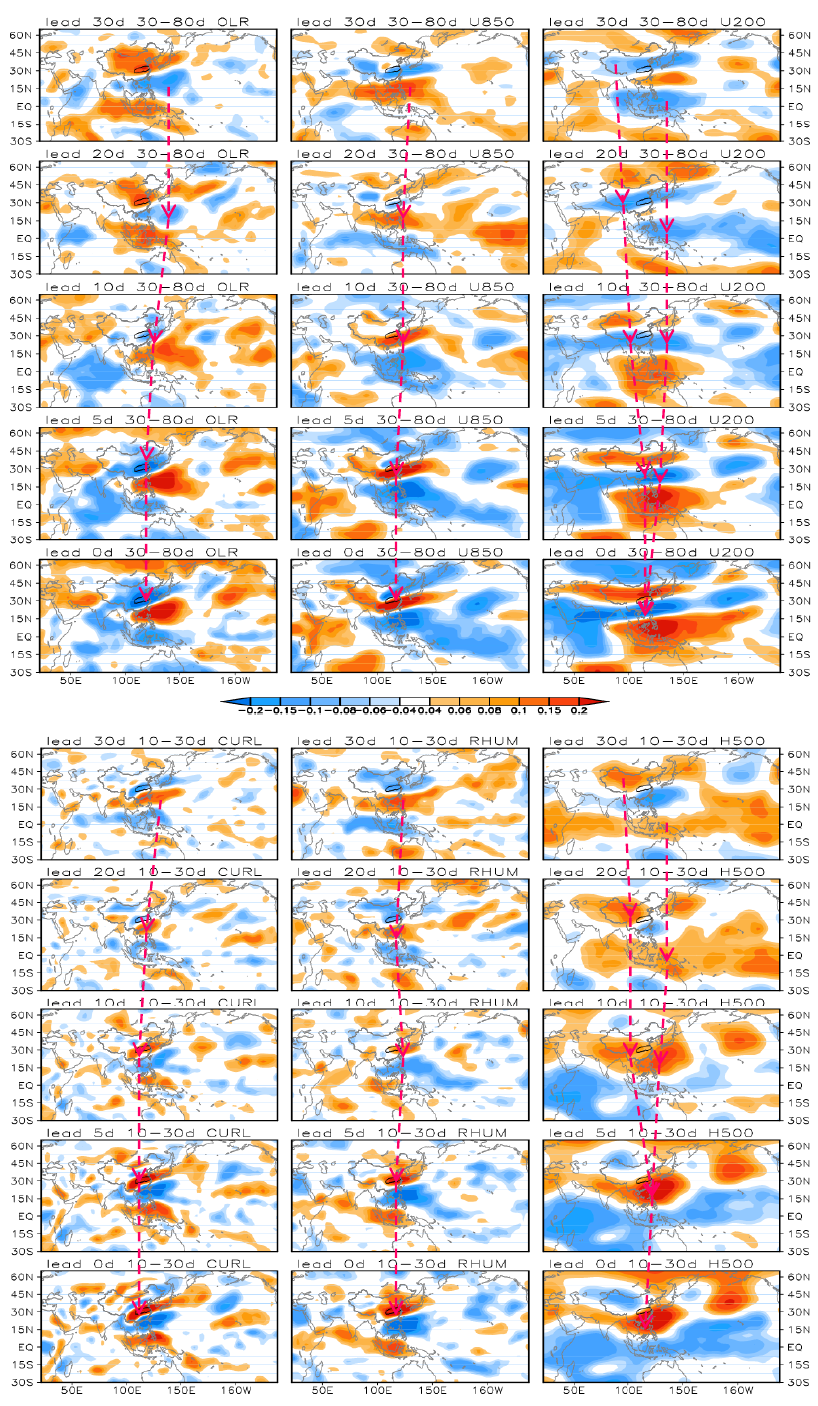
Figure 3. The 30–0-day lead (top to bottom: 30-, 20-, 10-, 5- and 0-day lead) correlation of six potential predictors (top-left to bottom-right: OLR, 850-hPa and 200-hPa zonal wind, 850-hPa relative vorticity, 700-hPa relative humidity, and 500-hPa geopotential height) fields with the 30–80-day MLRYB rainfall index. Shading indicates correlation coefficients. The dashed red line with arrows denotes the propagation of centers of predictability sources. The black contour denotes the MLRYB.